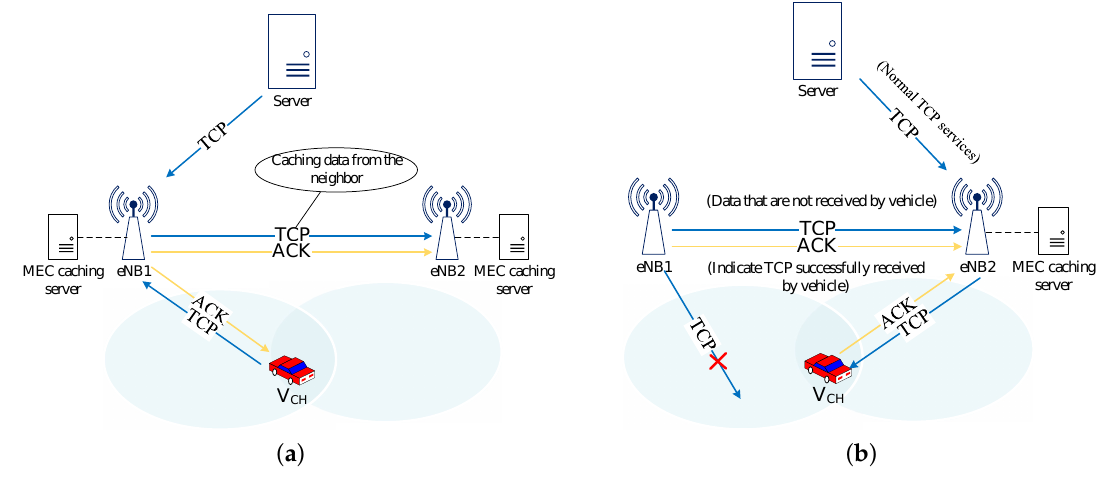
Figure 2. Caching scheme in handover process ( a ) eNB2 starts caching the data before handover; ( b ) eNB2 starts communications with